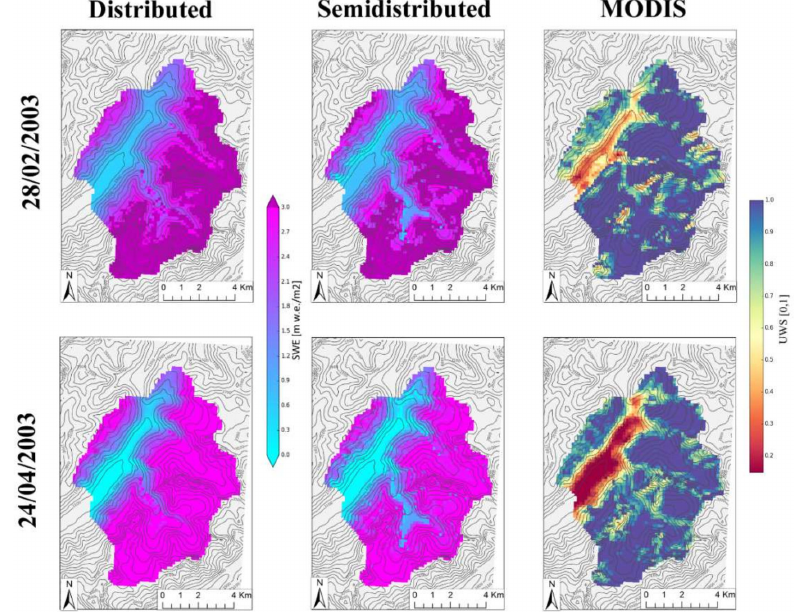
Figure 5. Spatial distribution of the Snow Water Equivalent (SWE) simulated with distributed (left panels) and semi-distributed (middle panels) approaches for the 28 February 2003 (upper panels) and for the 24 April 2003 (lower panels). Right maps show the UWS MODImLab product for same